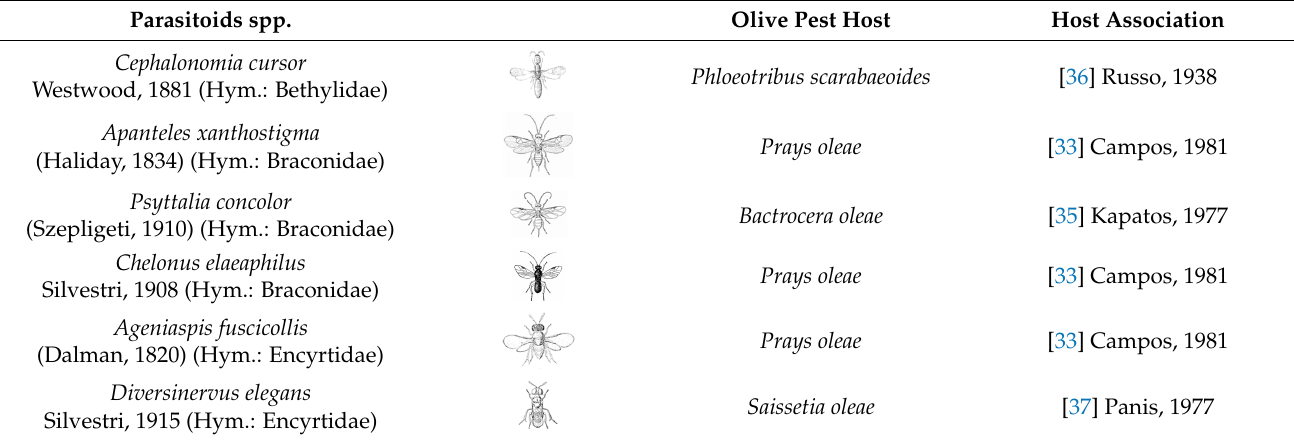
Table 2. Parasitoid species captured in the sticky yellow traps, pest species they are associated with, and first bibliographical